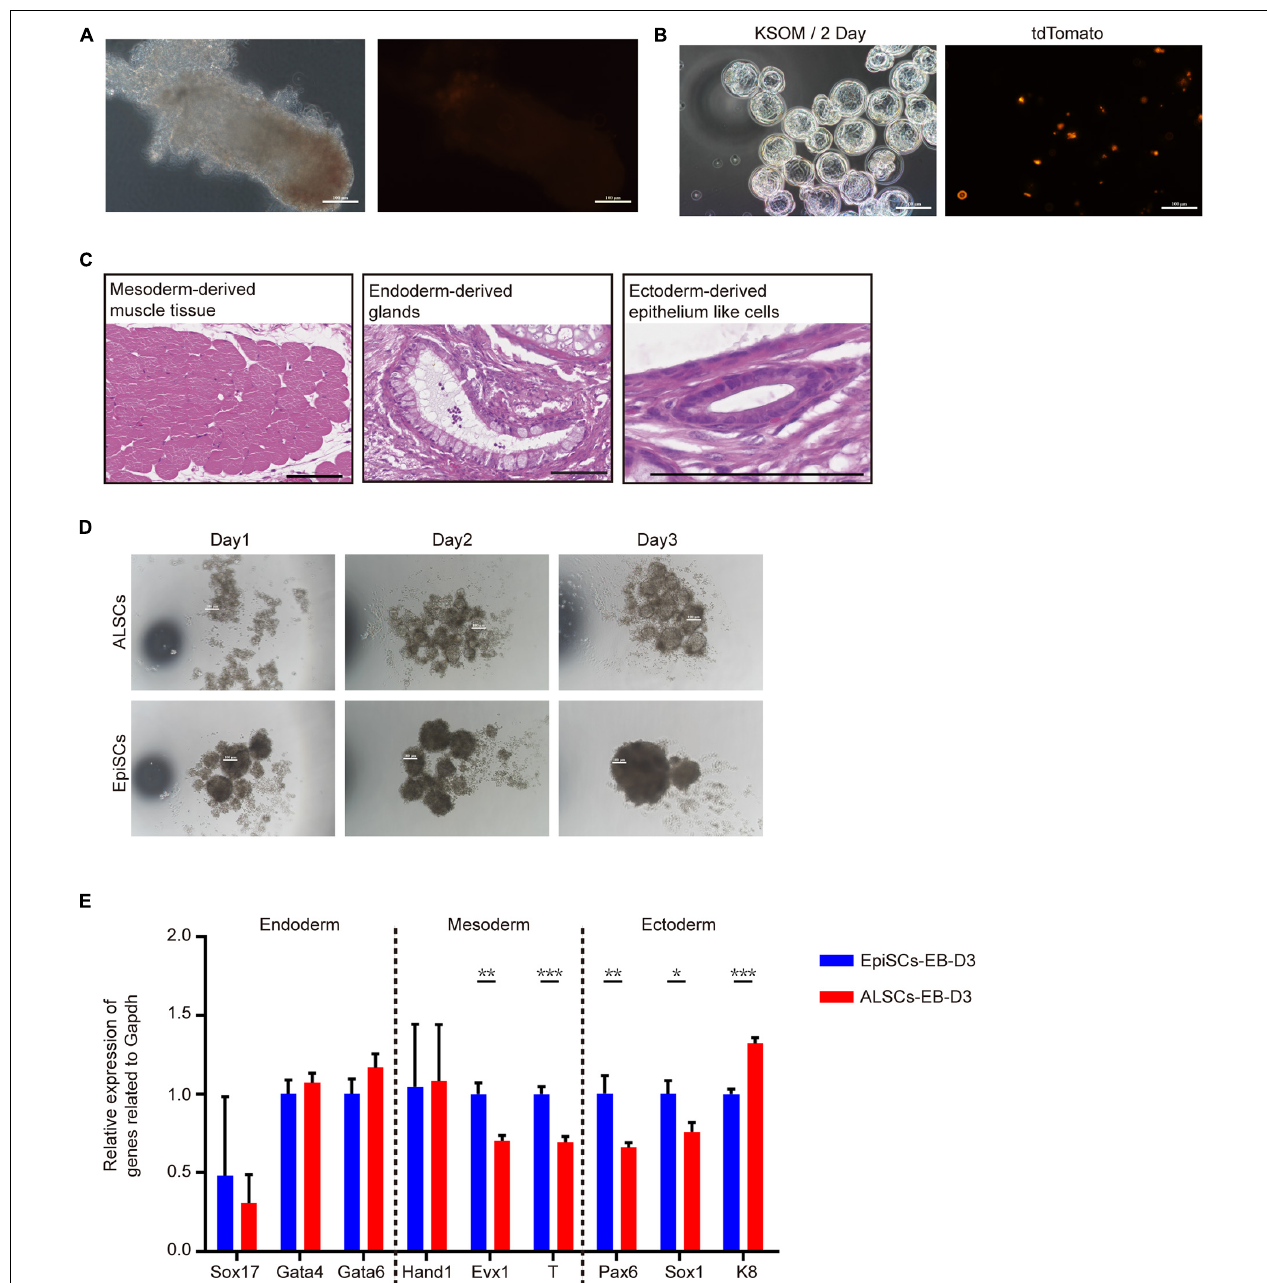
FIGURE 2 | The pluripotency of ALSCs. (A) E6.5 chimera collected by injecting ALSCs in host blastocysts. Scale bars, 100 µ m. (B) E3.5 chimeras generated by injecting ALSCs to eight-cell stage embryos followed culturing in KSOM for 2 days. Scale bars, 100 µ m. (C) ALSCs contributed to the generation of multiple tissues of germ layer in vivo by the teratoma test. Scale bars, 100 µ m. (D) Morphology of embryoid body induction by ALSCs and EpiSCs for 3 days. Scale bars, 100 µ m. (E) RT-qPCR of germ layer markers in embryoid bodies of ALSCs and EpiSCs after 3 days of culture. Error bars indicate three independent biological replicates (mean ± SD). *P < 0.05, * *P < 0.001, ** *P <